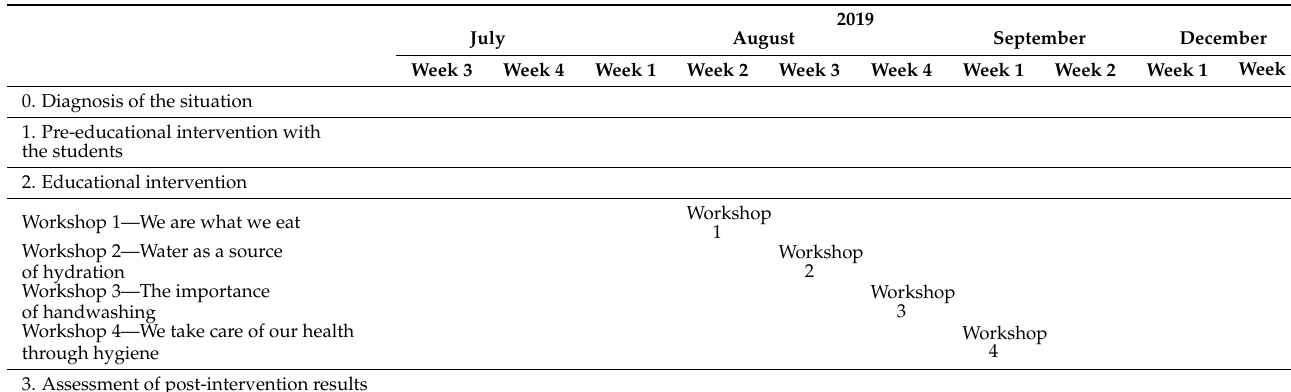
Table 1. Timeline of the educational intervention in Arenitas del Mar